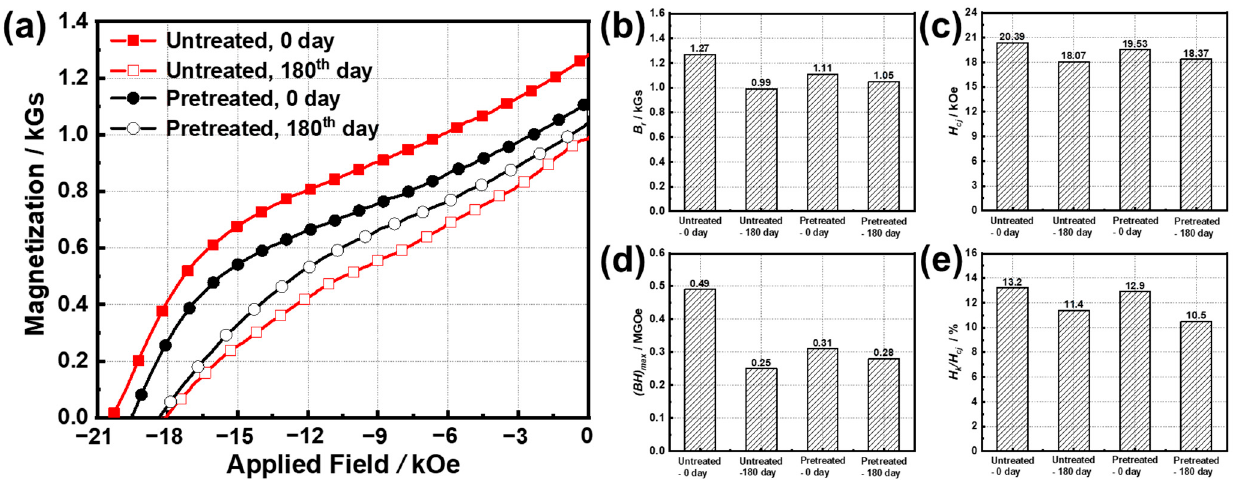
Figure 5. ( a ) Demagnetization curves, ( b ) B r , ( c ) H cj , ( d ) ( BH ) max , and ( e ) H k /H cj of the untreated and pretreated samples after oxidization in the air at 180 °C for 180 days.